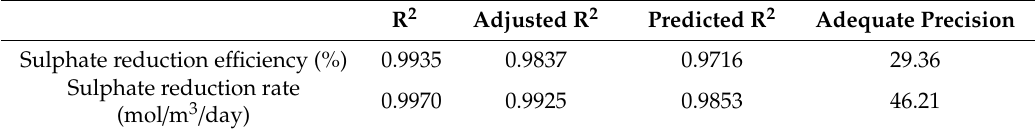
Table 4. Fit statistics.